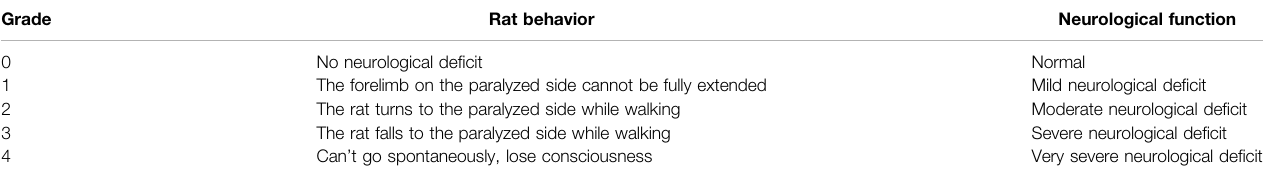
TABLE 1 | Zea-Longa neurological function score.